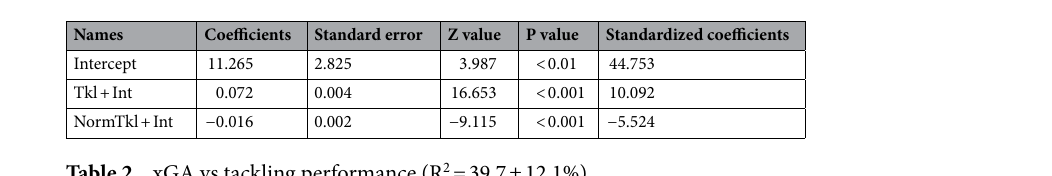
Table 2. xGA vs tackling performance (R 2 = 39.7 ± 12.1%).